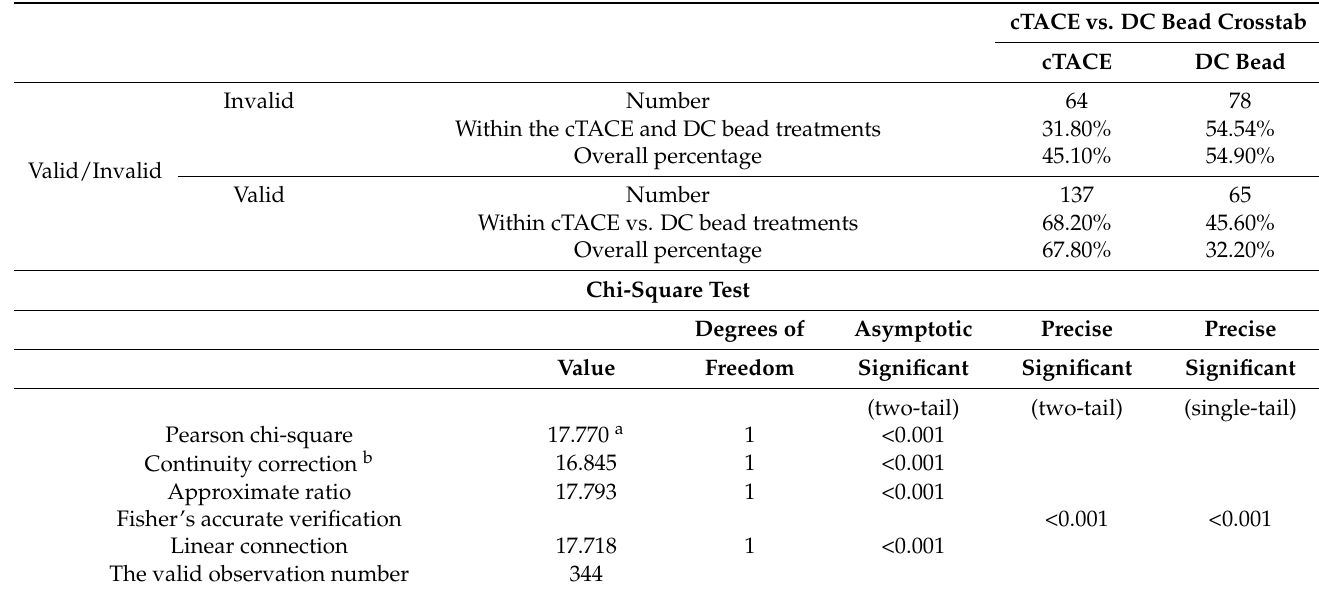
Table 2. cTACE vs DC Bead TACE Treatments.